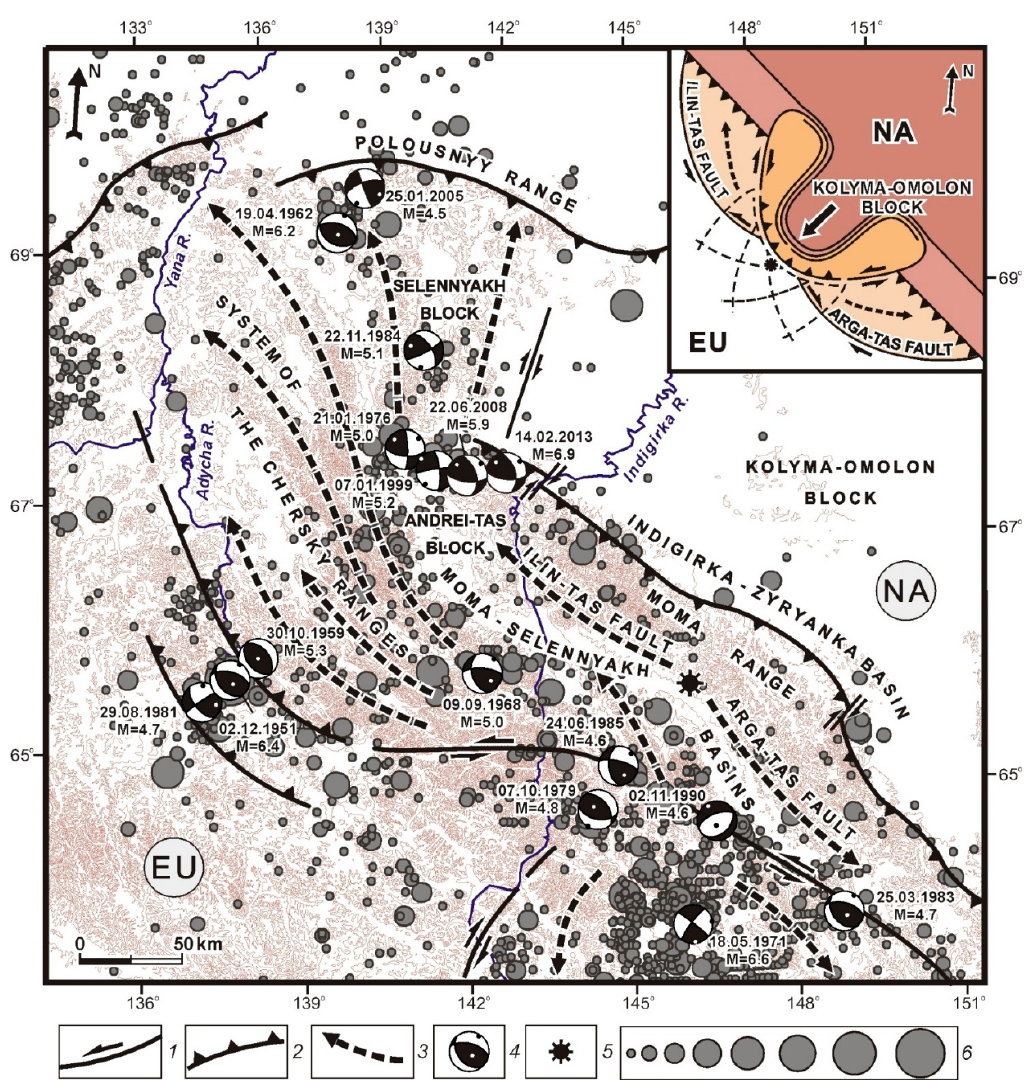
Figure 12. Scheme showing contemporary dynamics and earthquake epicenters in Yana–Indigirka segment of Chersky seismotectonic zone (after [26]). 1–2—kinematics of active faults: 1—strike-slip, 2—thrusts and reverse; 3—directions of movements of blocks; 4—focal mechanisms of earthquakes (lower hemisphere; the principal stress axes of compression and extension are marked by black and white dots, respectively); 5—Balagan–Tas volcano; 6—earthquake epicenters sized by magnitude: ≤ 3.0, 3.5, 4.0, 4.5, 5.0, 5.5, 6.0, ≥ 6.5.